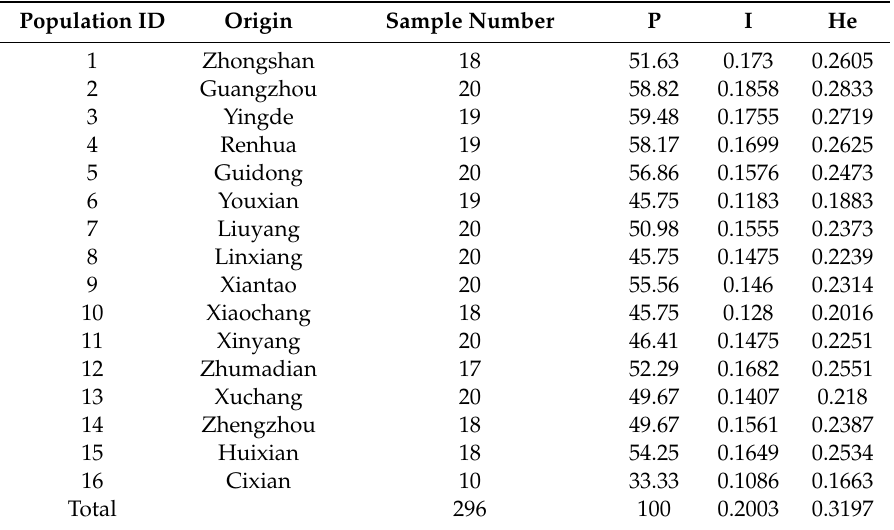
Table 2. Genetic diversity of 16 C. dactylon populations along latitudinal gradients. Population ID